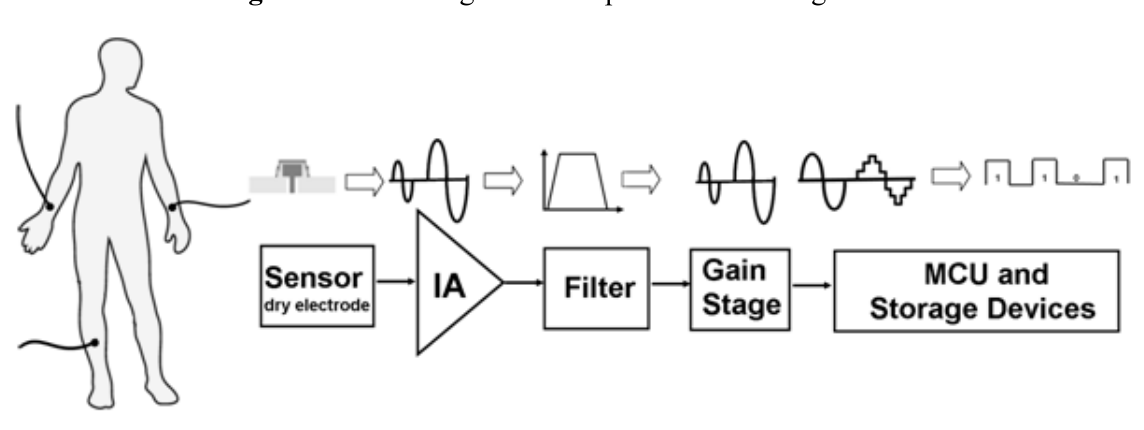
Figure 1. Block diagram of the portable recording